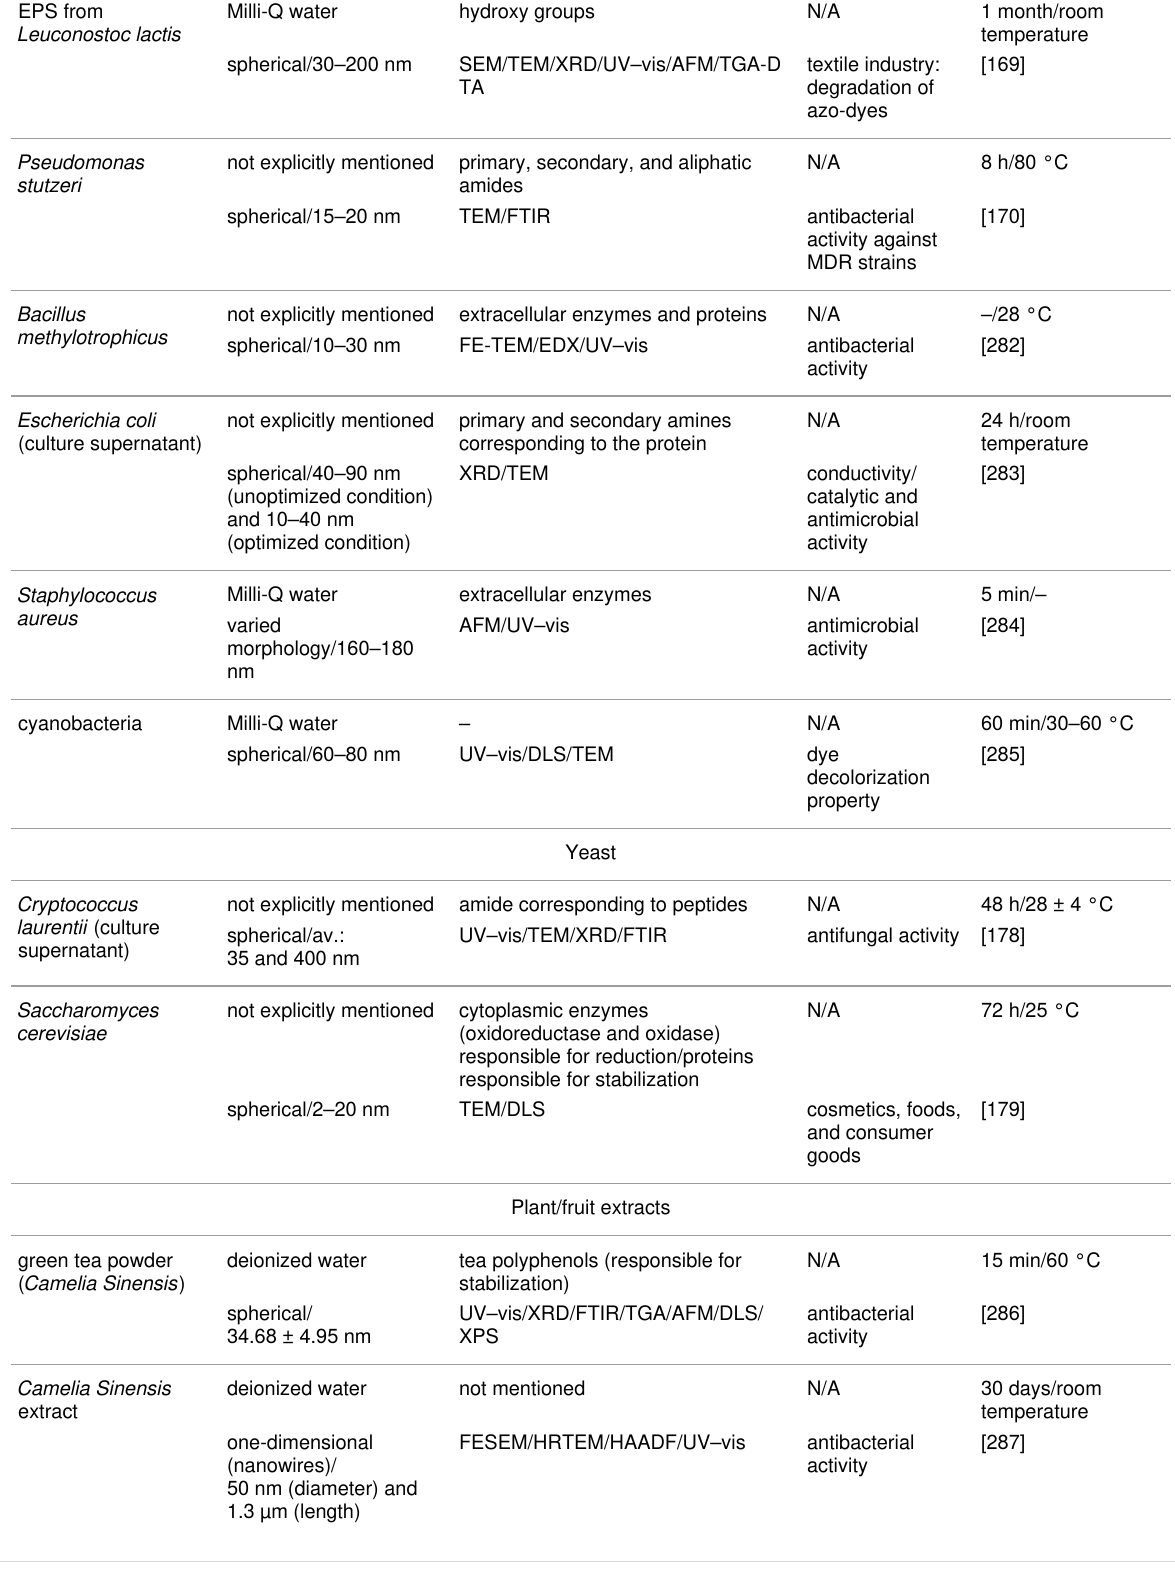
Table 2: A review of various green processes, reaction conditions, necessary functional groups, and characterization techniques used for the synthe- sis of silver nanostructures with different sizes and morphologies along with their application. (continued) EPS from Leuconostoc